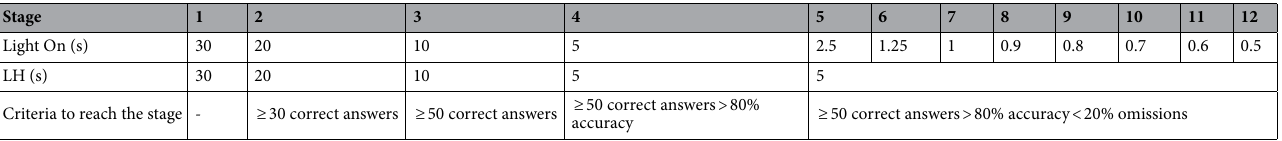
Table 1. The 12 stages of difficulty of the 5CSRTT. The length of the visual cue (‘Light On’) and the additional response window (LH, limited hold) decreases through the stages. Criteria to advance to each stage are provided in the last